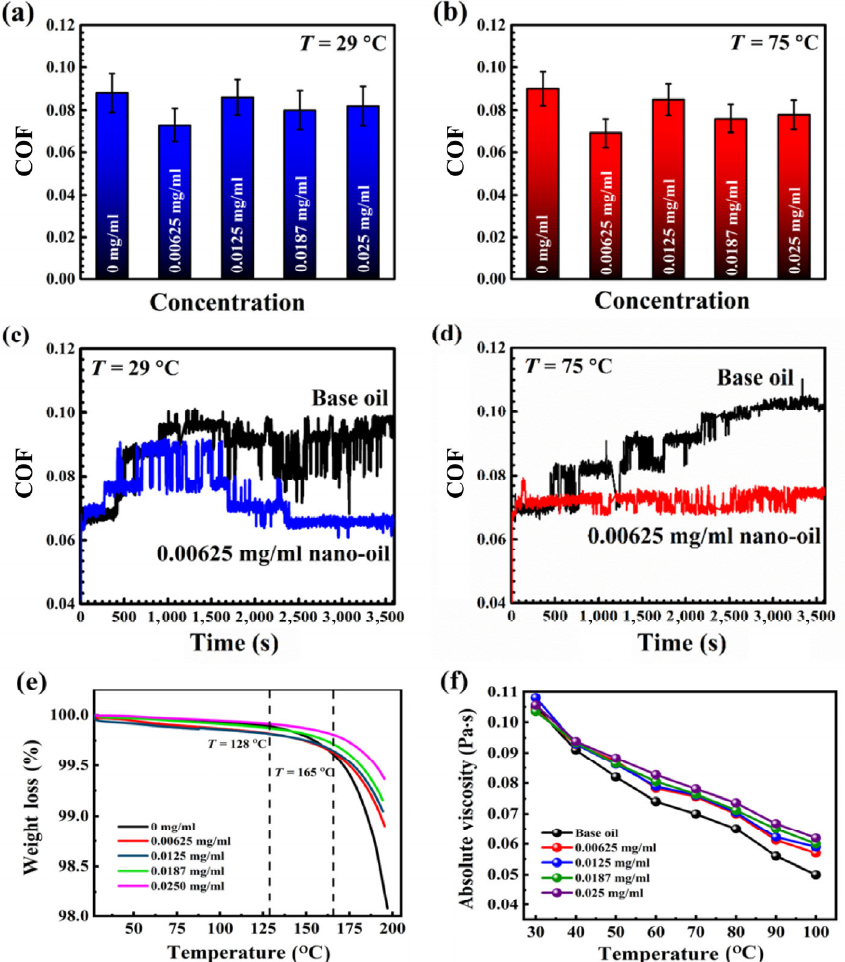
Fig. 5 COF variation with different concentrations of nano-oil at (a) 29 °C and (b) 75 °C. COF versus time for base and 0.00625 mg/ml nano-oil at (c) 29 °C and (d) 75 °C. (e) TGA and (f) absolute viscosity plot for each nano-oil